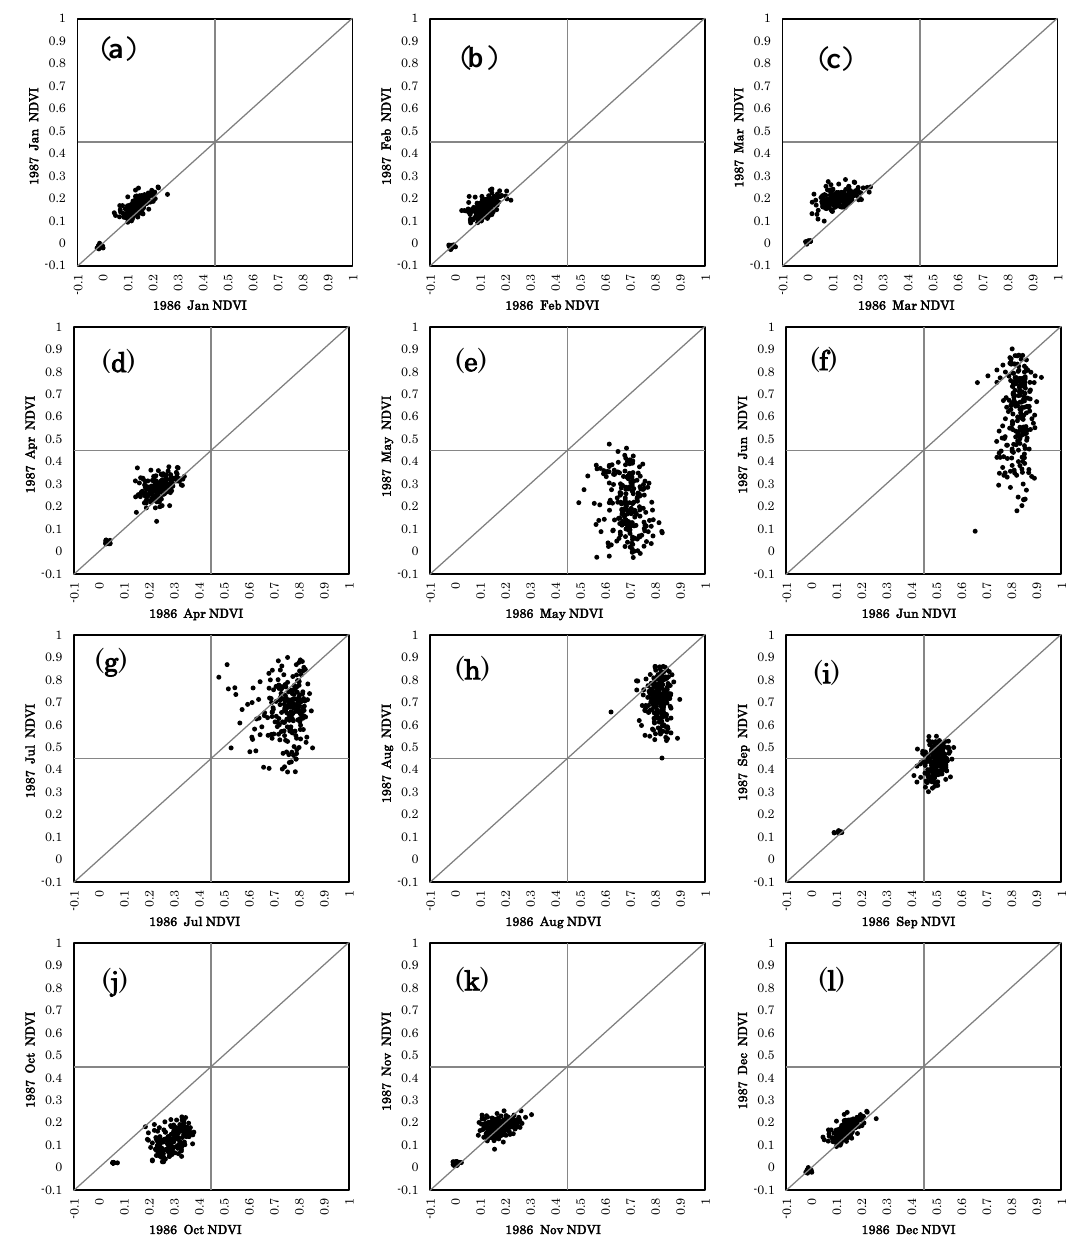
Figure 5. Monthly scatterplots of post-fire normalized difference vegetation index (NDVI) (1987) versus pre-fire NDVI (1986) (( a ) January, ( b ) February, ( c ) March, ( d ) April, ( e ) May, ( f ) June, ( g ) July, ( h ) August, ( i ) September, ( j ) October, ( k ) November, ( l ) December) for the large fire on May